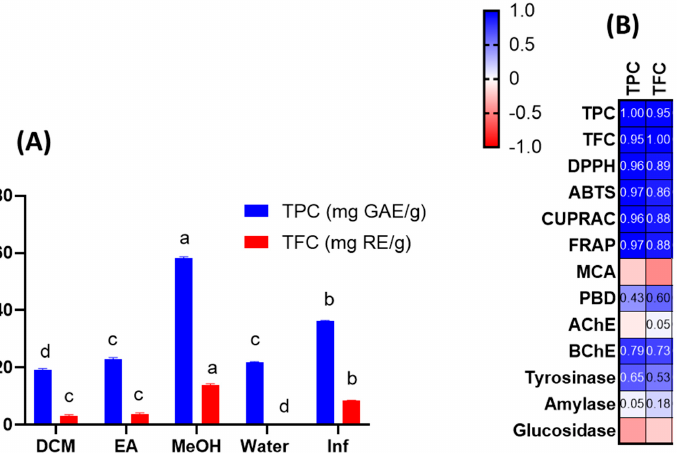
Figure 1. Total phenolic (TPC) and total flavonoid (TFC) content of the tested extracts ( A ). Pearson’s correlation values between total bioactive compounds and antioxidant and enzyme assays ( B ). Val- ues are reported as mean ± SD of three parallel measurements. GAE: gallic acid equivalents; RE: rutin equivalents. Different letters (a–d) in the columns indicate significant differences in the tested extracts (“a” indicated the highest content, p < 0.05). ABTS, 2,2 ′ -azino-bis (3-ethylbenzothiazoline) 6-sulfonic acid; AChE, acetylcholinesterase; BChE, butyrylcholinesterase; CUPRAC, cupric ion re- ducing antioxidant capacity; DPPH, 1,1-diphenyl-2-picrylhydrazyl; FRAP, ferric ion reducing anti- oxidant power; MCA, metal chelating activity; PBD, phosphomolybdenum activity; AChE: acetyl- cholinesterase; BChE: butrylcholinesterase.